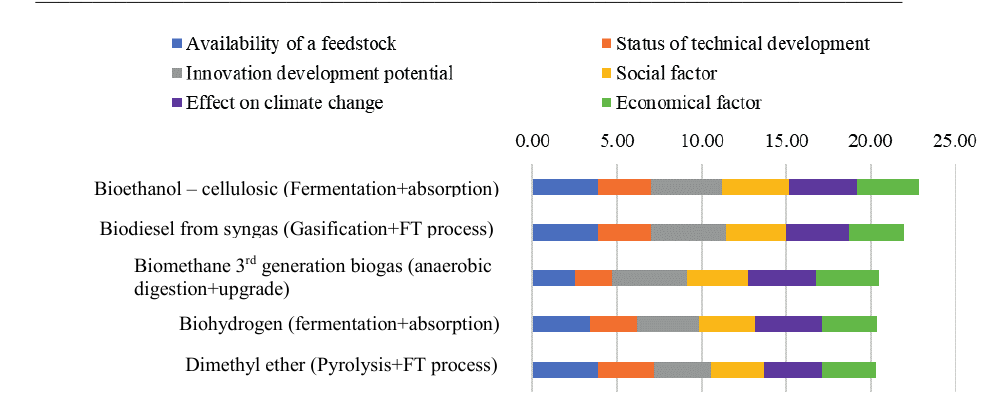
Fig. 1. Result ranking biofuels by the expert